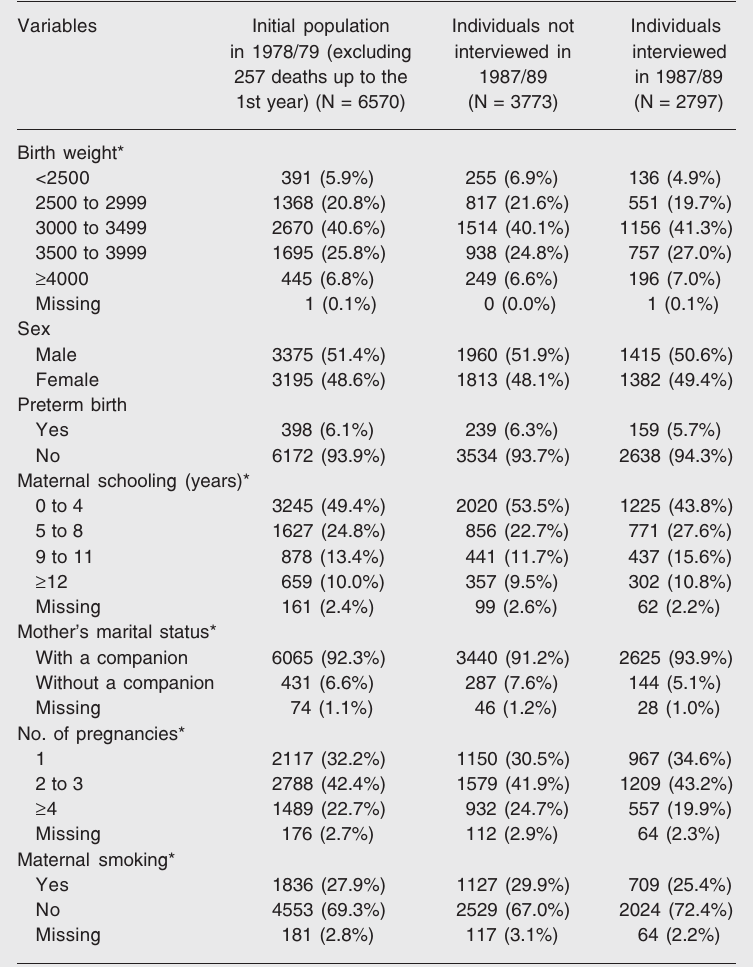
Table 1. Comparison of the characteristics of the cohort at birth with those who participated in the second phase of the study. Ribeirão Preto, 1978/79 and 1987/89. Variables Initial population Individuals